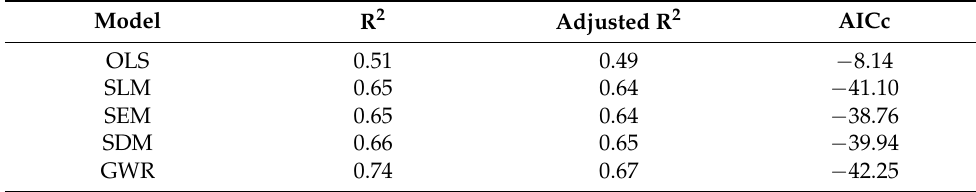
Table 3. Comparison of OLS, SLM, SEM, SDM, and GWR models.